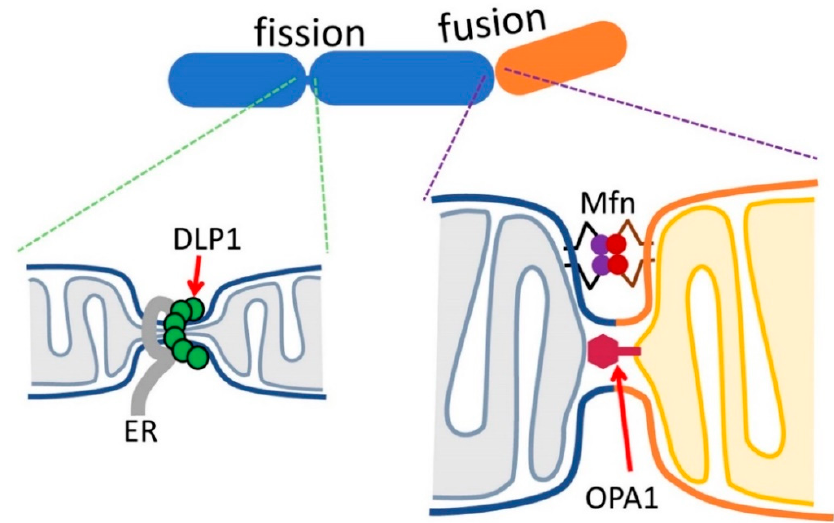
Figure 2. Mitochondrial fission and fusion by dynamin-related proteins. The ER (Endoplasmic reticulum) constricts mitochondria through a contractile force exerted from actin, myosin, and their associated proteins. DLP1 assembles at the constriction with the aid of its receptor and mediates fission through GTP hydrolysis. Final scission may require Dyn2. Mfn may interact in a head-to-head manner to tether and fuse opposing OMs. IM-anchored OPA1 may bind to the opposing IM for fusion. Two isoforms of mitofusin, Mfn1 and Mfn2, are the OM fusion dynamins. Mfn1 and Mfn2